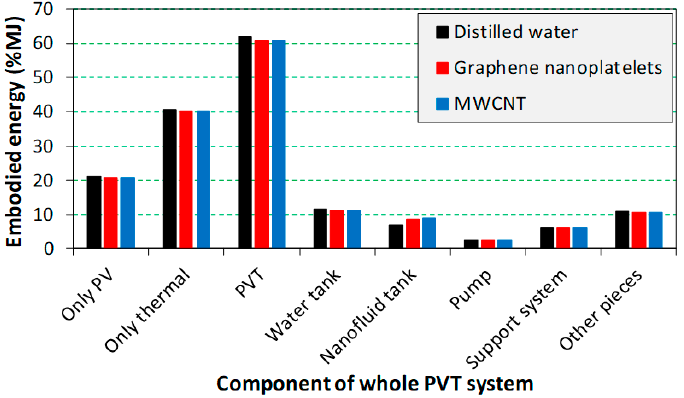
Figure 9. Percentage changes in environmental impact vs. embodied energy in the components of the experimental setup. Table 4. General results of the thermal, LCA, and CED analyses for the experimental